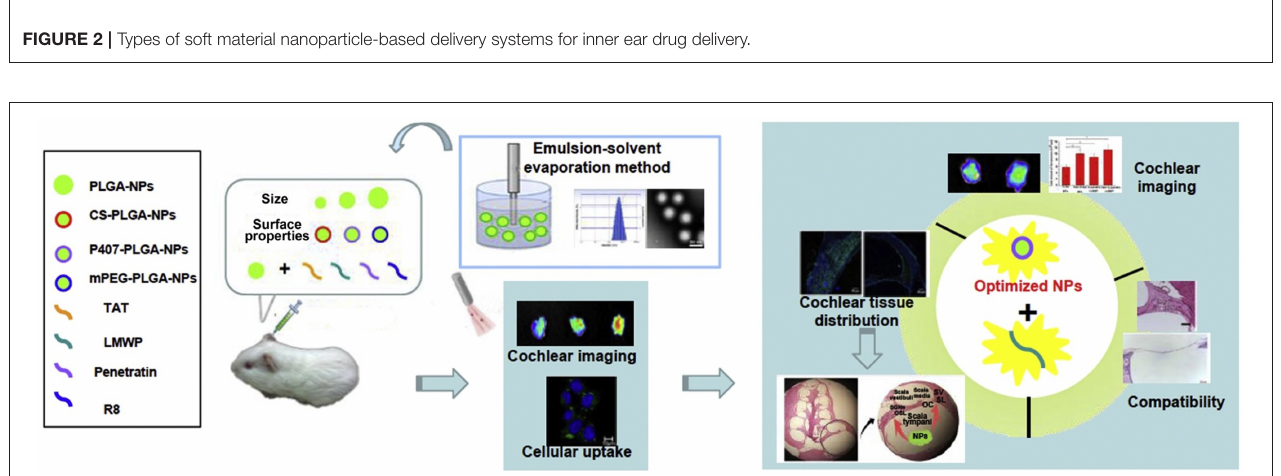
FIGURE 3 | Poly(lactic- co -glycolic acid) (PLGA) nano-based systems with cell-penetrating peptides for cochlear drug delivery. Reprinted with permission from Cai et al. (2017) . Copyright 2017 Published by Elsevier B.V.